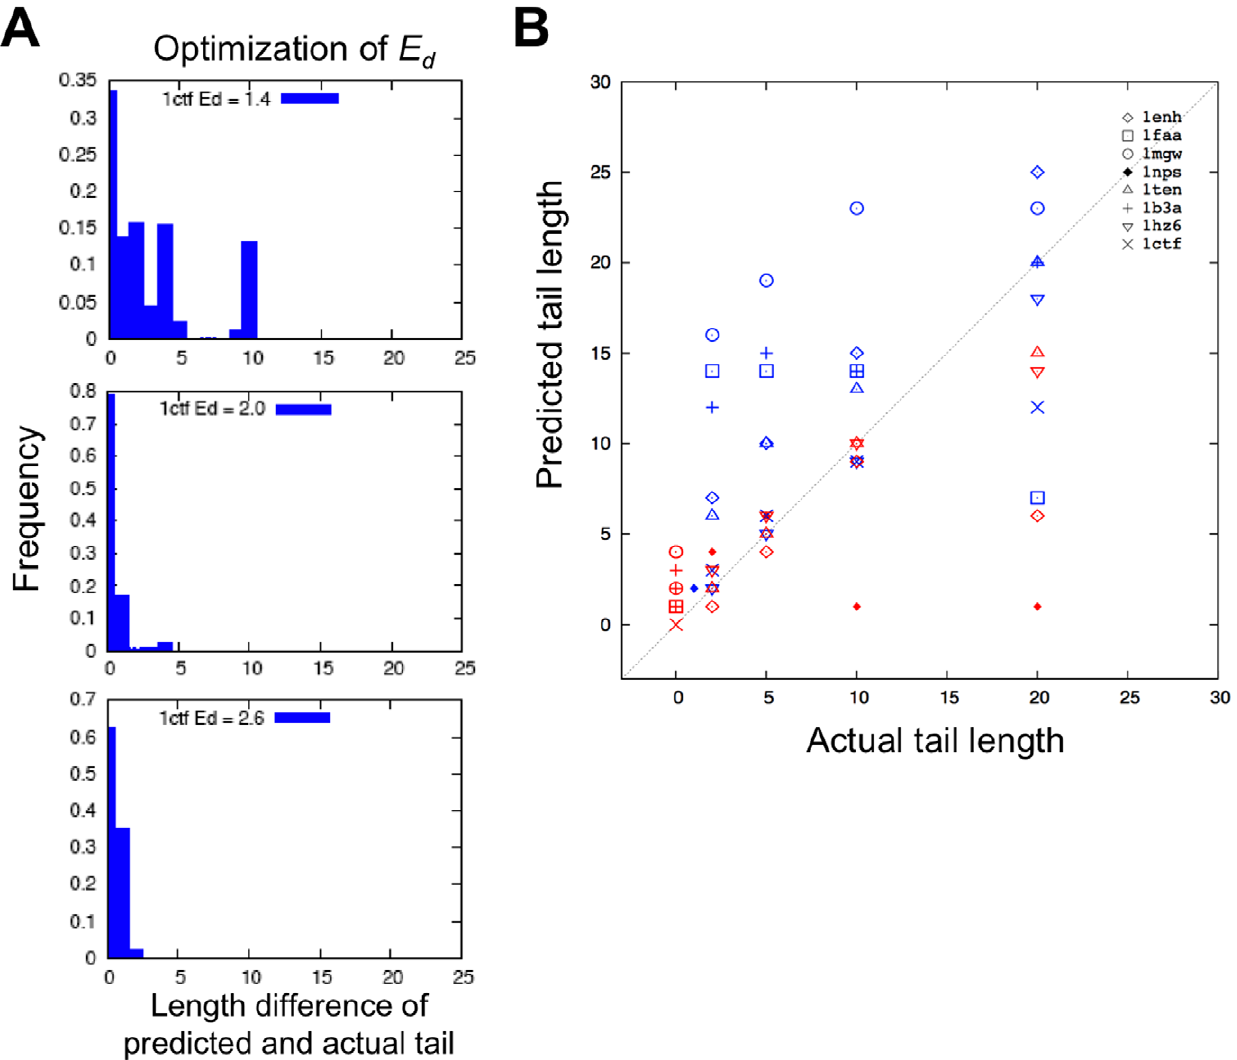
Figure 1. Results of disordered termini prediction. ( A ) Optimization of E d value using 1ctf from the test set as a representative example. In panel 1 to 3, histograms show the accuracy of prediction results using representative of E d values, where the x-axis shows the length difference of predicted and actual tail, and the y-axis shows the frequency of prediction. We show here the prediction results with E d values of 1.4, 2.0 and 2.6 in panel 1, 2 and 3, respectively. With the E d value of 2.0, the prediction shows the greatest accuracy, where the predicted length difference equals to zero (the prediction matches the actual length) with the highest frequency of 0.8 (maximum equals to 1). ( B ) Prediction of disordered terminal regions. Blue and red symbols represent N- and C- terminal tails, respectively. Different symbols corresponds to different test cases; the multiple instances of each symbol type represent the different tail lengths considered for a given test case.